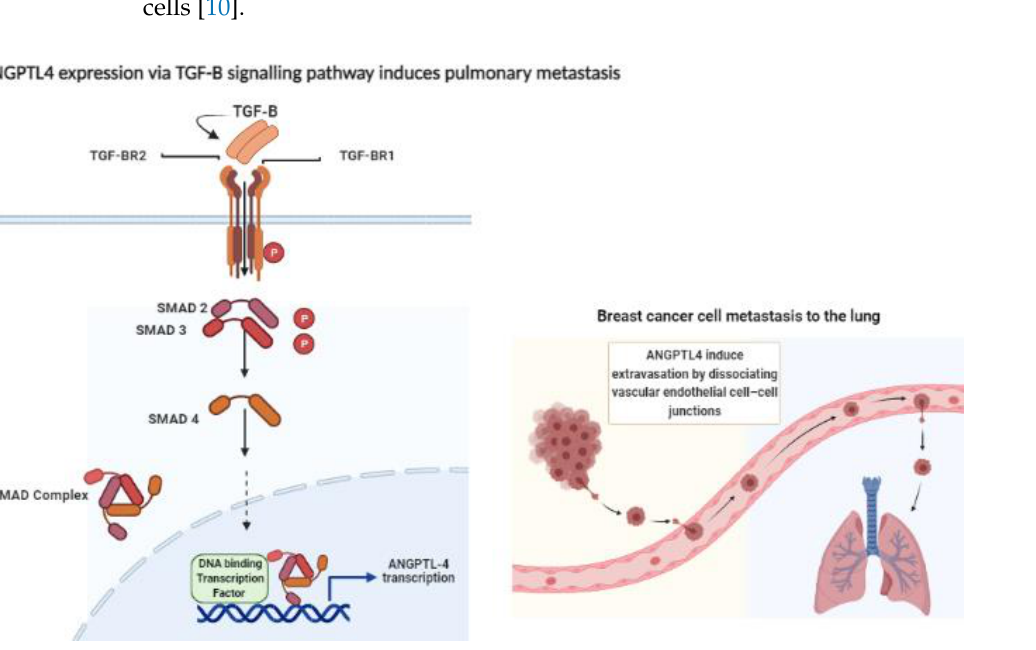
Figure 1. Expression of ANGPTL4 through TGF-B – SMAD signaling enhances the extravasation of the breast cancer cell to the lungs by disrupting of the vascular endothelial cell-cell -junction. Trans- forming growth factor-B (TGF-B) ligand binds to transforming growth Factor-B receptor I (TGFBR1) and transforming growth factor-B II (TGFBR2). TGFBR2 phosphorylates (P) TGFBR1, which in turn